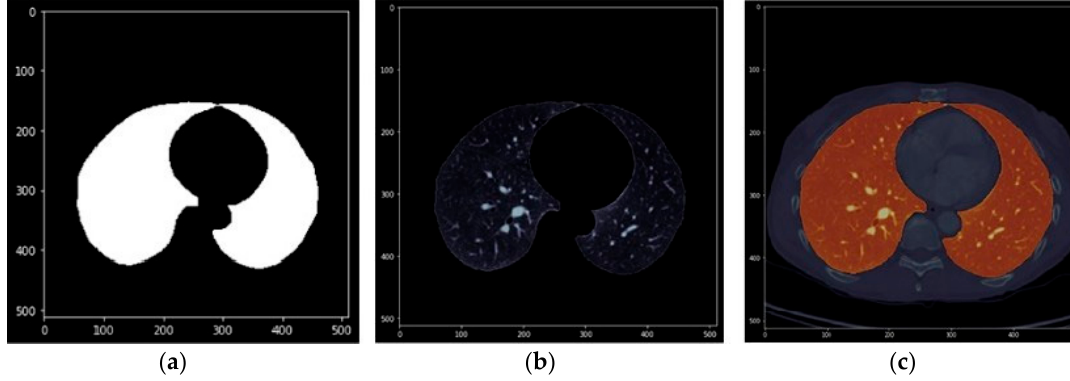
Figure 11. Complete lung segmentation. ( a ): Binary mask; ( b ): DICOM with binary mask applied; ( c ): DICOM with binary mask overlapped and highlighted.